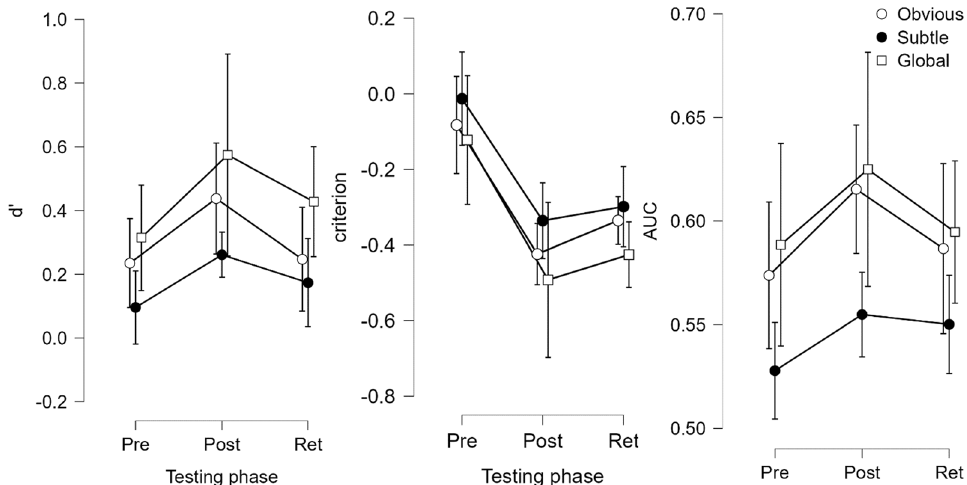
Fig. 5 Mean d’, criterion, and AUC across test phases ( image type (‘circle’ Obvious, ‘Bullet’ Subtle, ‘Square’